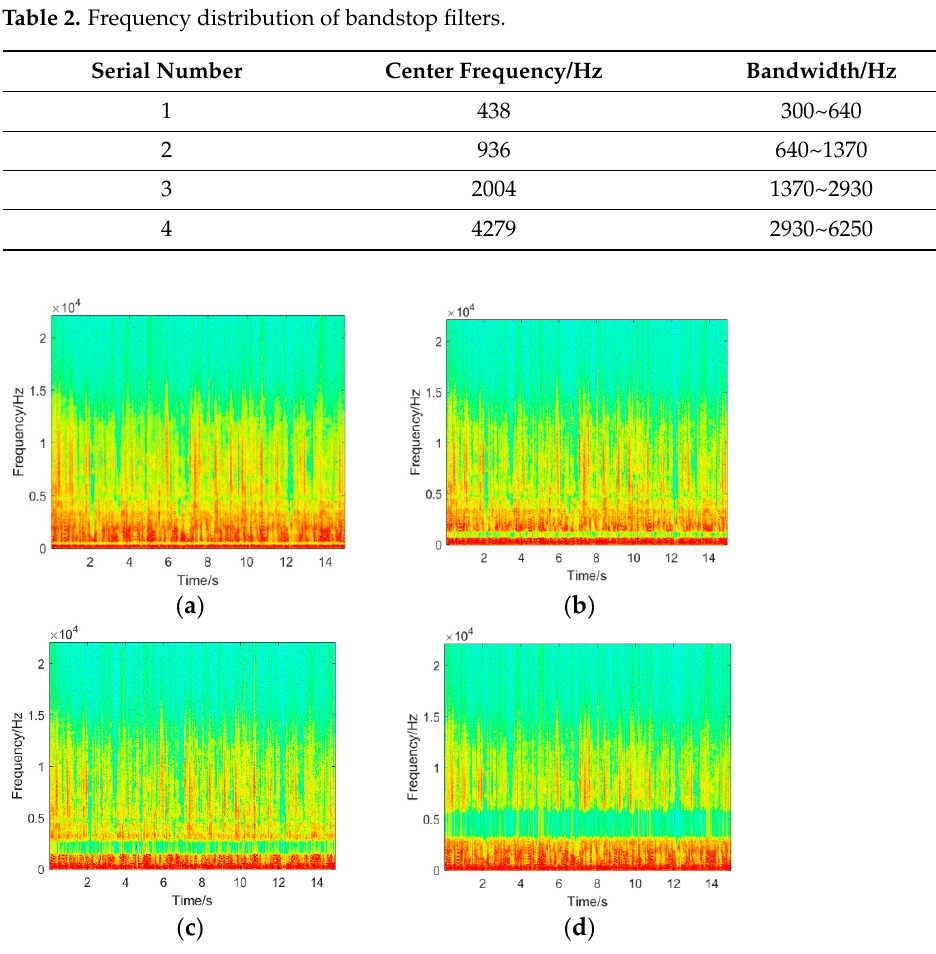
Figure 5. Four spectrograms of speech noise after removing a certain frequency band. ( a ) 300~640 Hz; ( b ) 640~1370 Hz; ( c ) 1370~2930 Hz; ( d ) 2930~6250